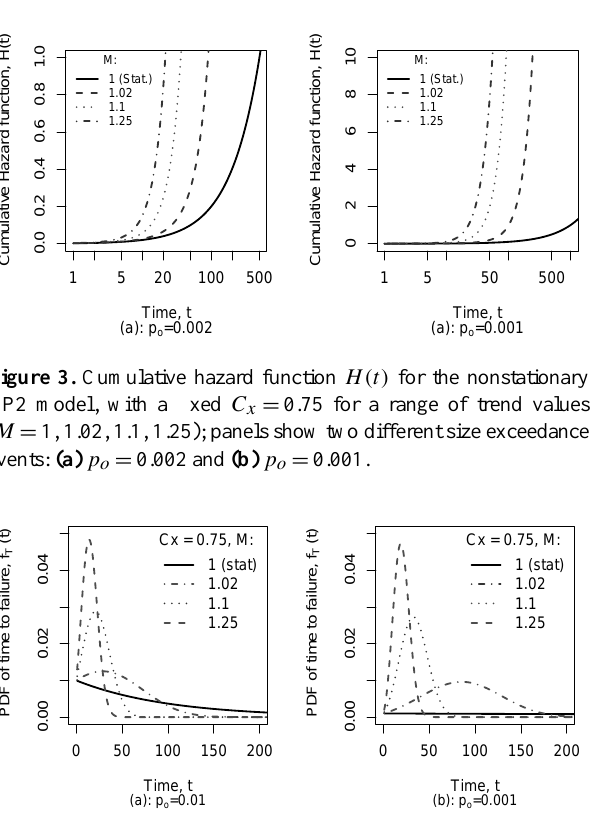
Figure 4. PDF of the time to failure distribution for the nonstation- ary GP2 model, with a fixed C x = 0.75 for a range of trend values ( M = 1, 1.02, 1.1, 1.25); panels show three exceedance event sizes increasing in extremity: (a) p o = 0.01 and (b) p o =